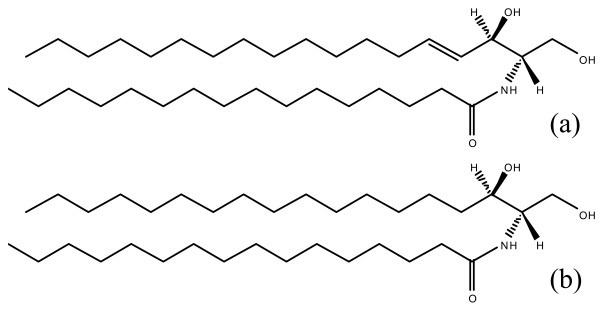
Chemical structure of (a) C16 Cer and (b) C16 DHCer.